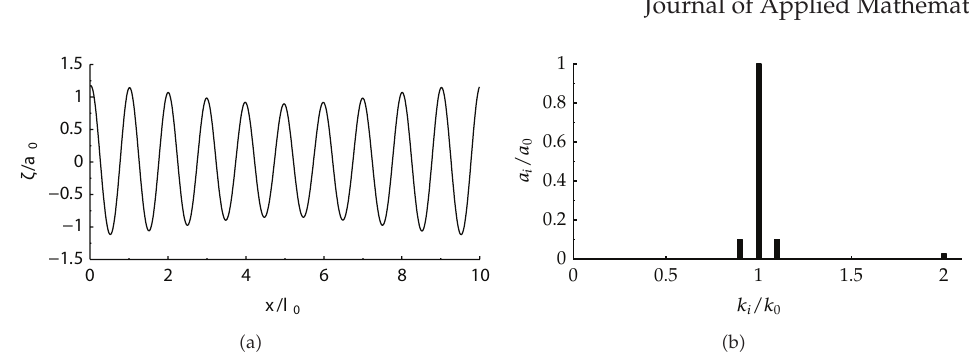
Figure 1: Sketch of initial surface elevation and wave number spectrum of Stokes modulated wave train for ε 0 (cid:7) 0 . 05 , k 0 (cid:7) 10 , r 1 (cid:7) 0 . 1 , M (cid:7) 4 , N (cid:7) 1024 , T 0 / Δ t (cid:7)